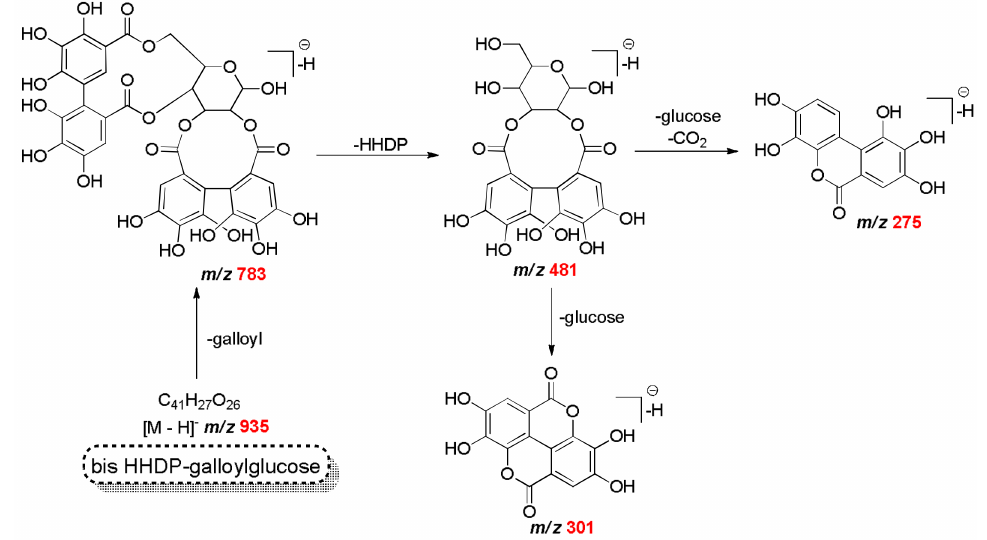
Scheme 2. The proposed fragmentation pathways of